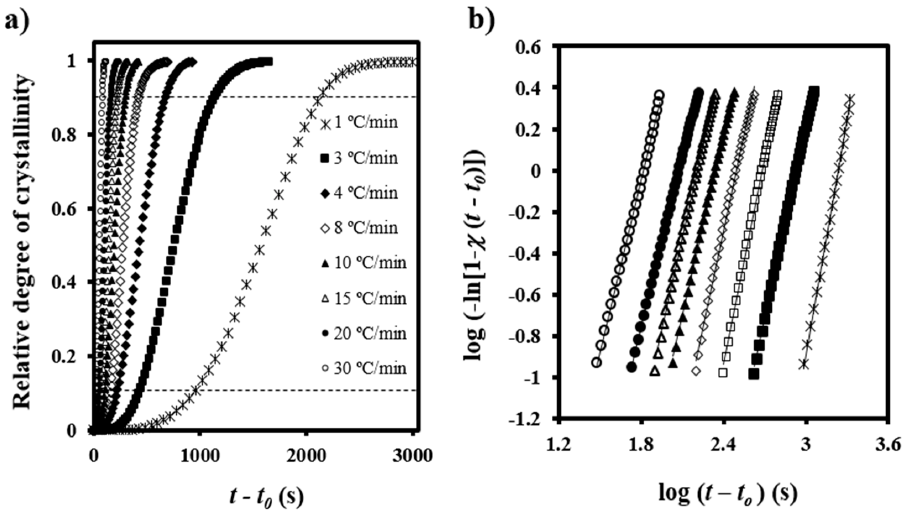
Figure 3. ( a ) Time evolution of relative crystallinity at the indicated cooling rates for non-isothermal crystallization of PDO; ( b ) Avrami analyses of non-isothermal crystallizations of PDO.